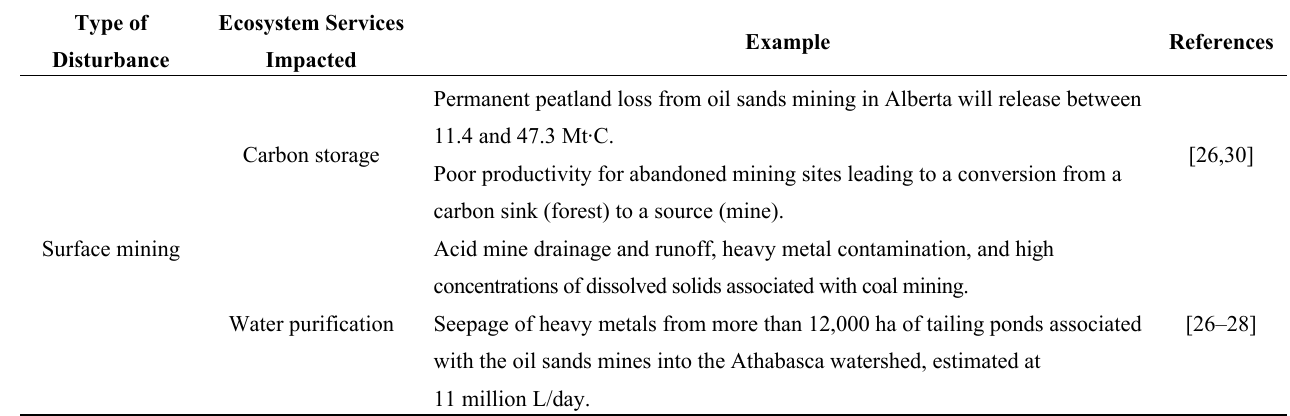
Table 1. Examples of oil and gas impacts on forest ecosystem